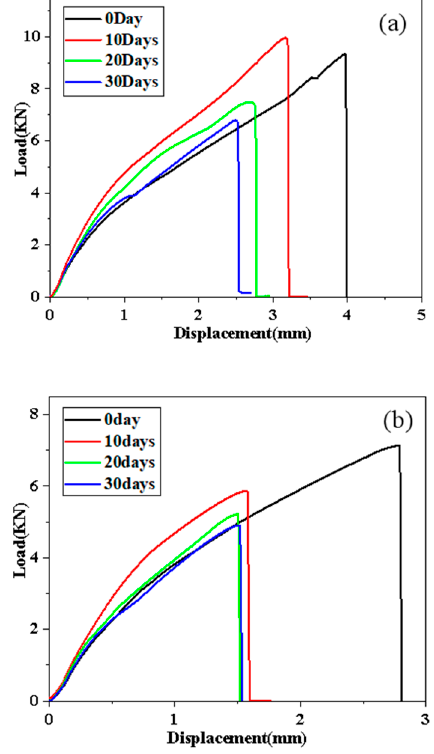
Figure 9. The most representative load displacement curves of different aging stages were obtained: